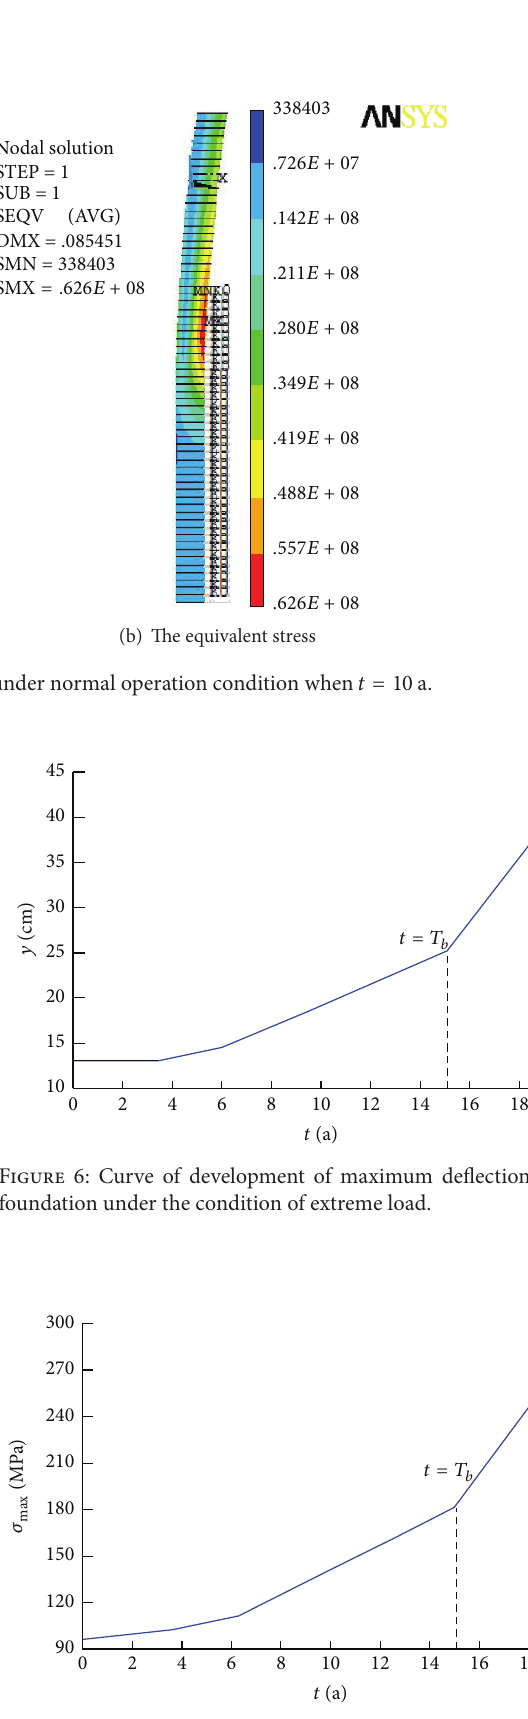
Figure 7: Curve of development of maximum stress of pile founda- tion under the condition of extreme